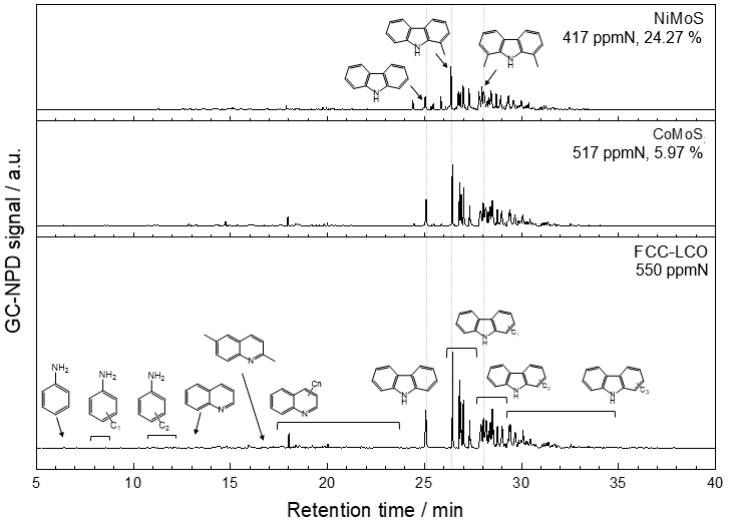
Figure 5. N compound distribution in LCO and after 2 h of HDN over CoMoS and NiMoS catalysts at 613K.